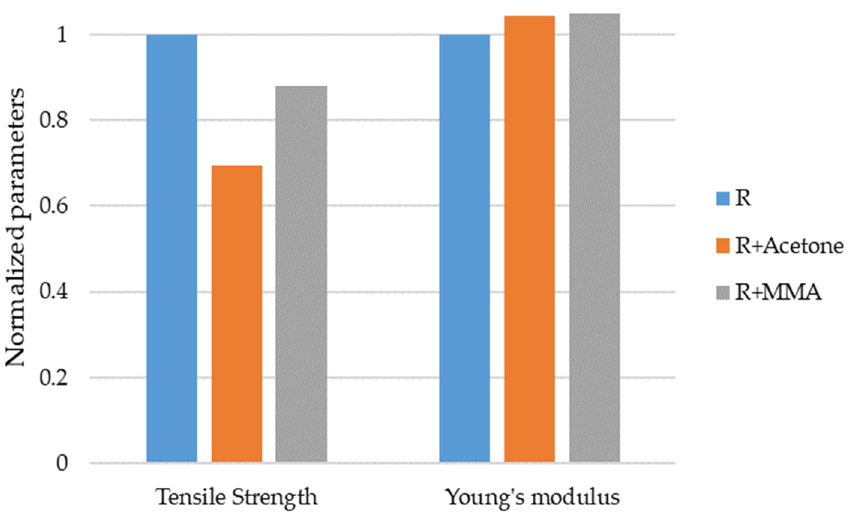
Figure 3. Effect of acetone and MMA on tensile properties of the resin.